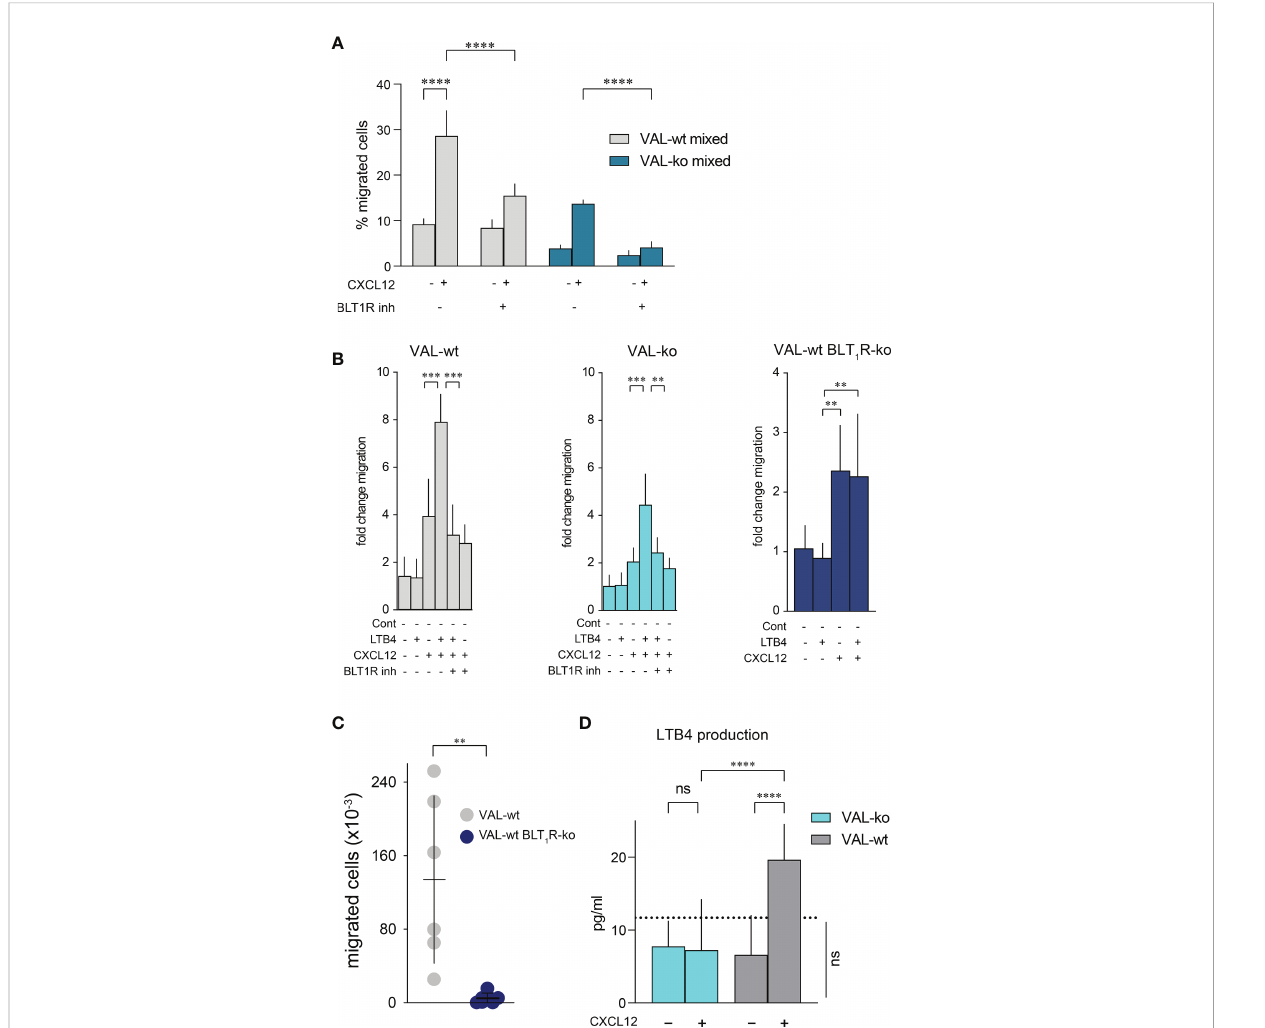
FIGURE 6 CXCL12 and LTB4 synergistically induce the migration of DLBCL. (A) Transmigration through mLEC was performed and calculated as described in Figure 1. Migration towards 10 nM CXCL12 of VAL-wt in a 1:1 mixture with VAL-ko (VAL-wt mixed, grey bars) and VAL-ko in a 1:1 mixture with VAL-wt (VAL-ko mixed, dark cyan bars) was measured in the absence and presence of 1 µM of the BLT1R inhibitor, BIIL315. Cumulative data of three independent experiments performed in triplicates (means ± SD, ONE WAY ANOVA, Turkey ’ s multiple comparisons test, ****p ≤ 0.0001). (B) VAL cells were embedded in a collagen matrix on the transwell insert. Fold change of VAL-wt (left, grey bars), VAL-ko (middle, cyan bars) and VAL-wt with deleted blt 1 r gene (right, blue bars) migrating in response to 10nM LTB4 and 10 nM CXCL12 in the absence and presence of 1 µM BLT1R inhibitor (BIIL315) as indicated. Cumulative data from three experiments performed in quadruplicates (means ± SD, Student ’ s t-test **p ≤ 0.01 ***p ≤ 0.001). (C) Total number of VAL-wt (gray dots) and VAL-wt lacking BLT 1 R (dark blue dots) present in the draining axillary lymph node. Lymph node cells were analyzed by fl ow cytometry and gated for hCD19 + (HIB19 or SJ25C1) and mCD45 - (30-F11) expression (means ± SD, t-test single comparison, **p ≤ 0.01). (D) LTB4 production (pg/mL) by VAL-wt and VAL-ko in absence or presence of 10 nM CXCL12. Values below the dashed line are under the sensitivity level. Cumulative data of three independent experiments performed in duplicates or quadruplicates (mean ± SD, ONE WAY ANOVA, Turkey ’ s multiple comparison test, ****p ≤